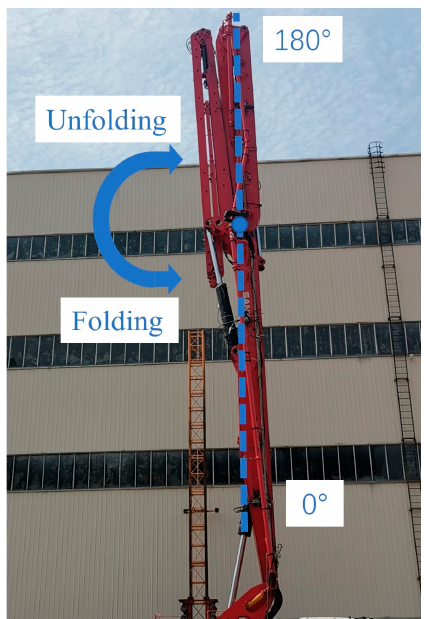
Figure 19. Movement schematic of boom section